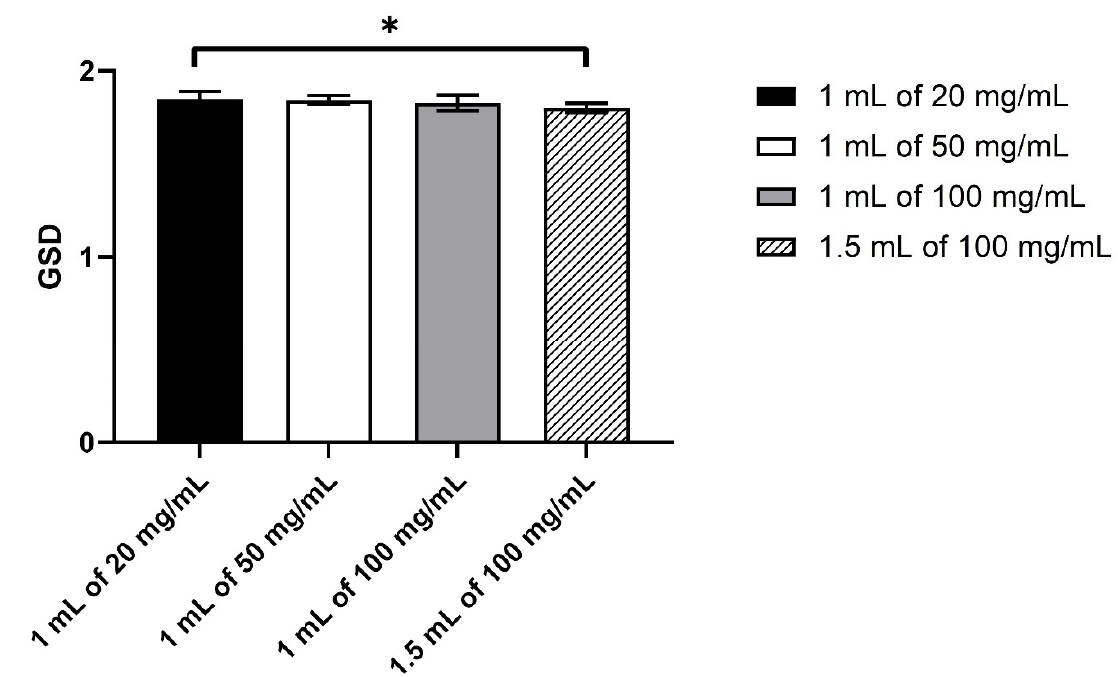
Figure 4. The volumetric median diameter of the droplets measured by laser diffraction. Data pre- sented as mean ± standard deviation ( n = 9). Statistical difference indicated by * ( p < 0.05).